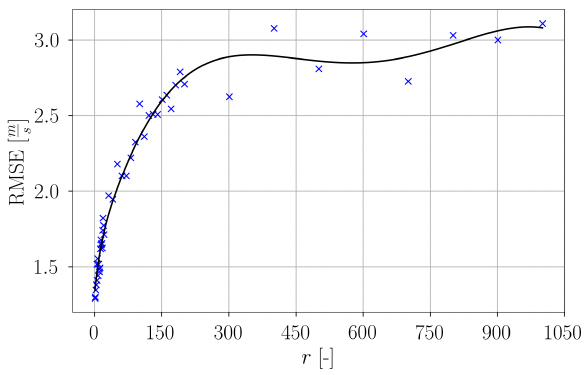
Figure 32. Reconstruction error over the number of used basis